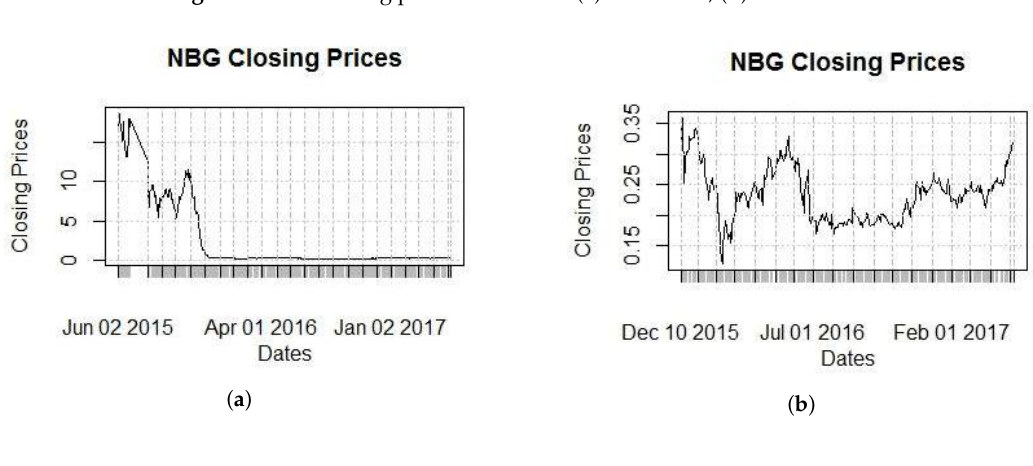
Figure 3. NBG closing prices 2015–2017. ( a ) 2015–2017 (I); ( b ) 2015–2017